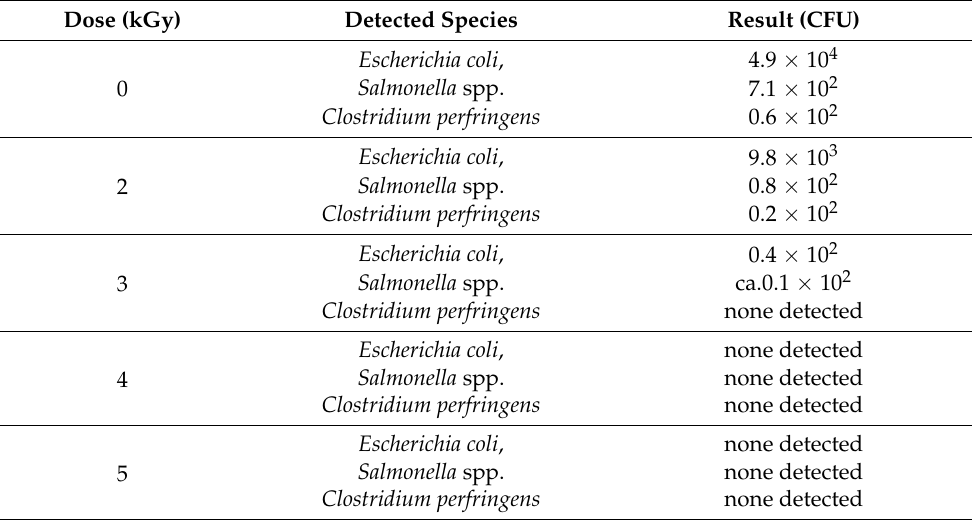
Table 2. Results of the analysis of E.coli , Salmonella spp., and Clostridium perfrigens presence in postflotation sludge from WWTP